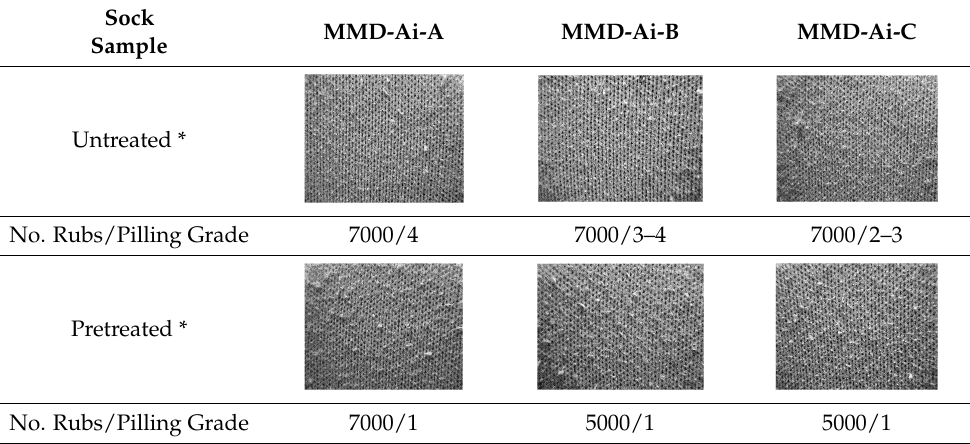
Table 7. Surface appearance of the untreated and pretreated sock plain knits made from micro modal air-jet spun yarns (MMD-Ai) at the end of the pilling test.